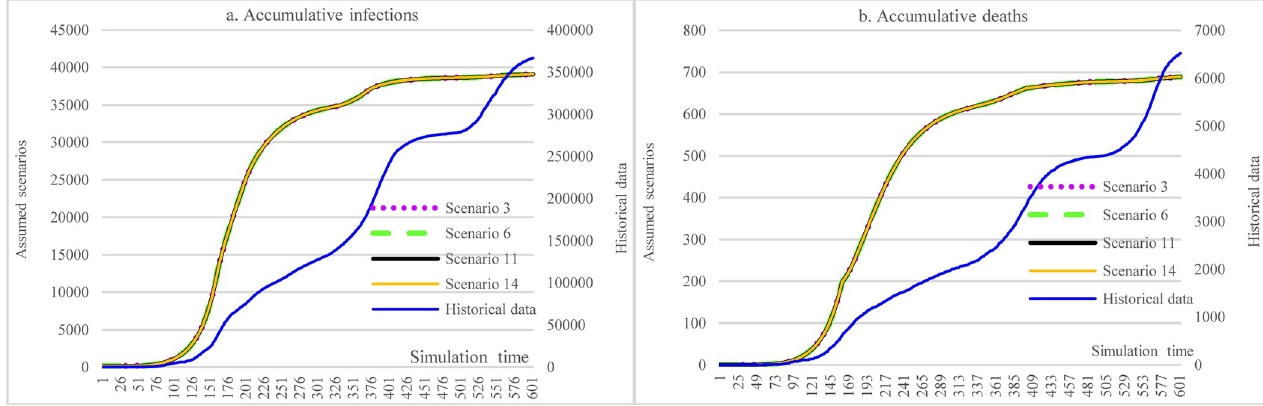
Fig 6. Impacts of enforced social distancing for both social events and routine life activities in counterfactual analysis.